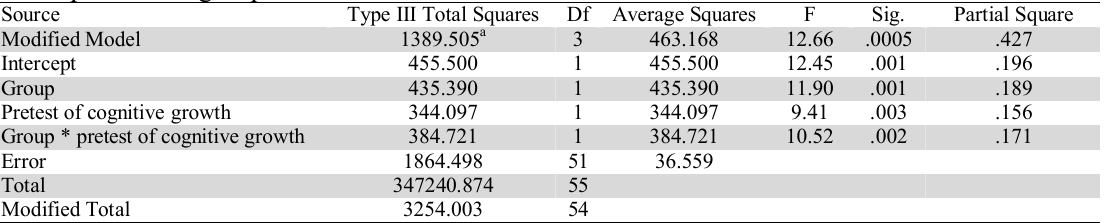
Results of one-way ANCOVA in dependent cognitive growth variable in scores of posttest of control and experimental groups